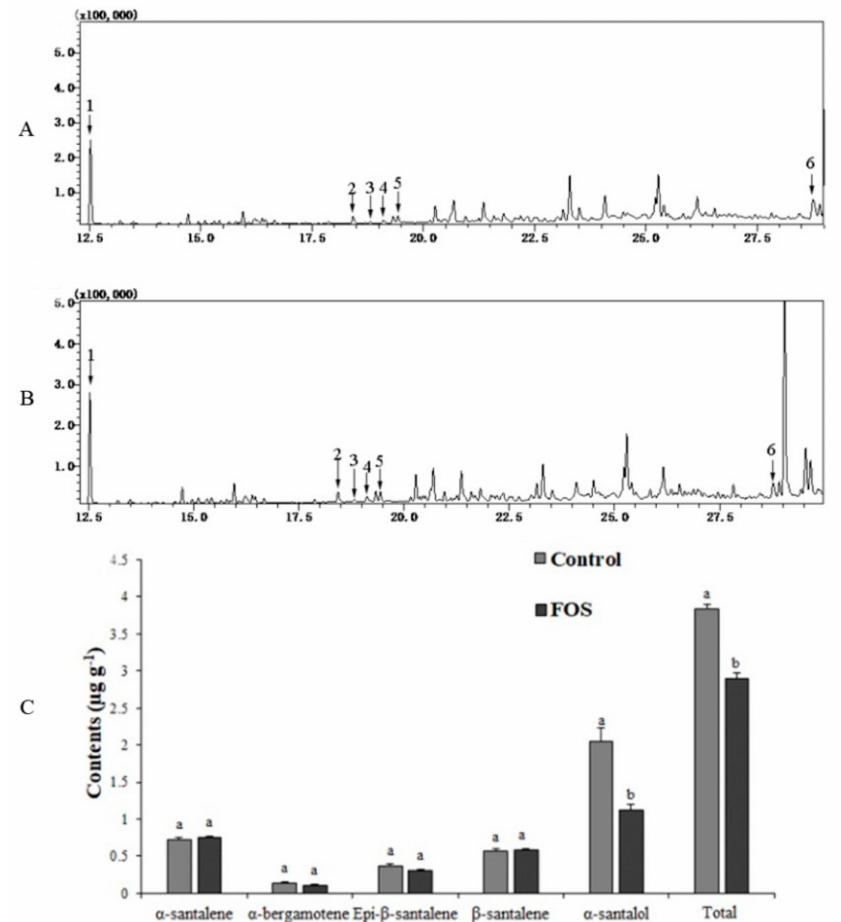
Figure 11. Profile of sandalwood sesquiterpenoids in the roots of the control and FOS-treated 8- month-old seedlings. ( A , B ) Total ion chromatogram (TIC) of control and FOS-treated seedlings roots, respectively. ( C ) Relative contents of sandalwood sesquiterpenoids (1, dodecane; 2, α -santalene; 3, α -bergamotene; 4, epi- β -santalene; 5, β -santalene; 6, α -santalol) were identified by comparison to NIST05, NIST05s and the Wiley 9 library. Each value represents the means of three independent biological replicates ± SD. Different letters above bars indicate significant differences between FOS and the control for each sesquiterpenoid (DMRT, p <